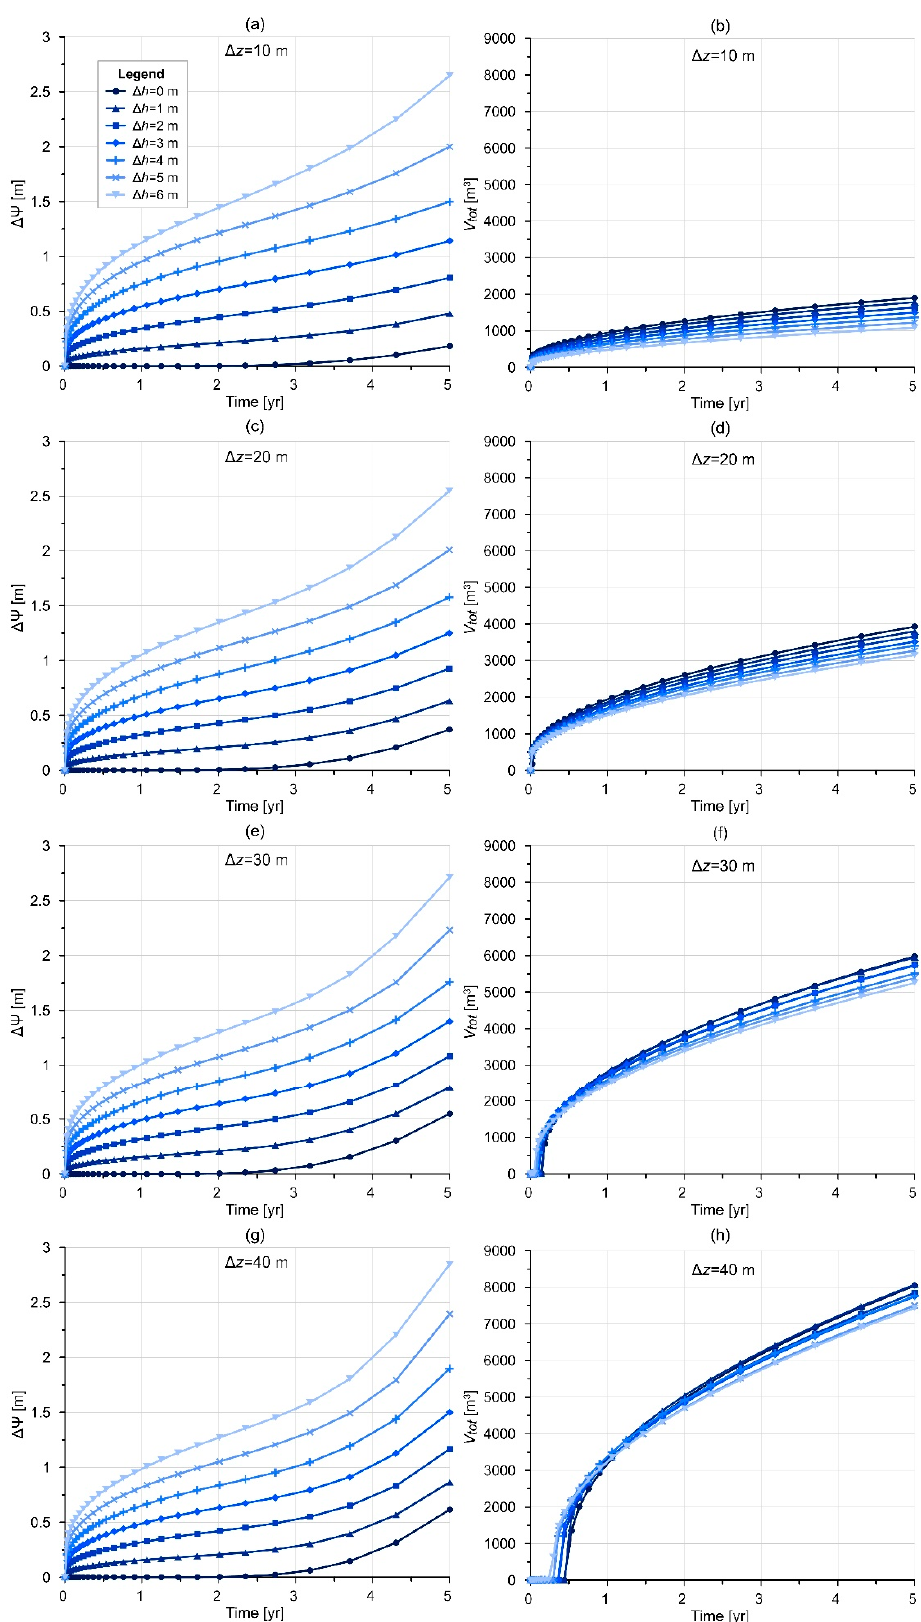
Figure 3. Water level increase ( ΔΨ ) and cumulative water volume infiltrating from the infiltration basin ( V tot ) in time (( a , b ): Δ z = 10 m, ( c , d ): Δ z = 20 m, ( e , f ): Δ z = 30 m, ( g , h ): Δ z = 40 m) for SG ‐ 1.